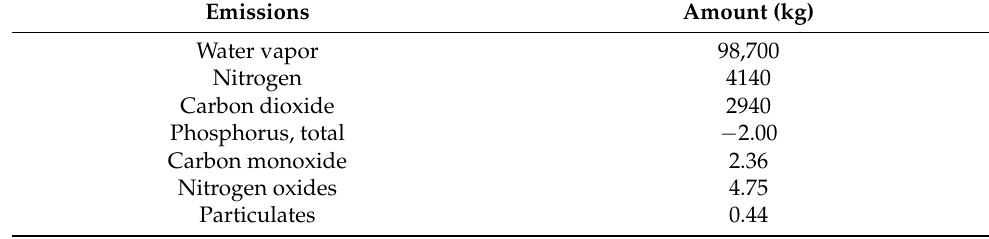
Table 6. Forest residue-to-water treatment total pathway emissions per day.